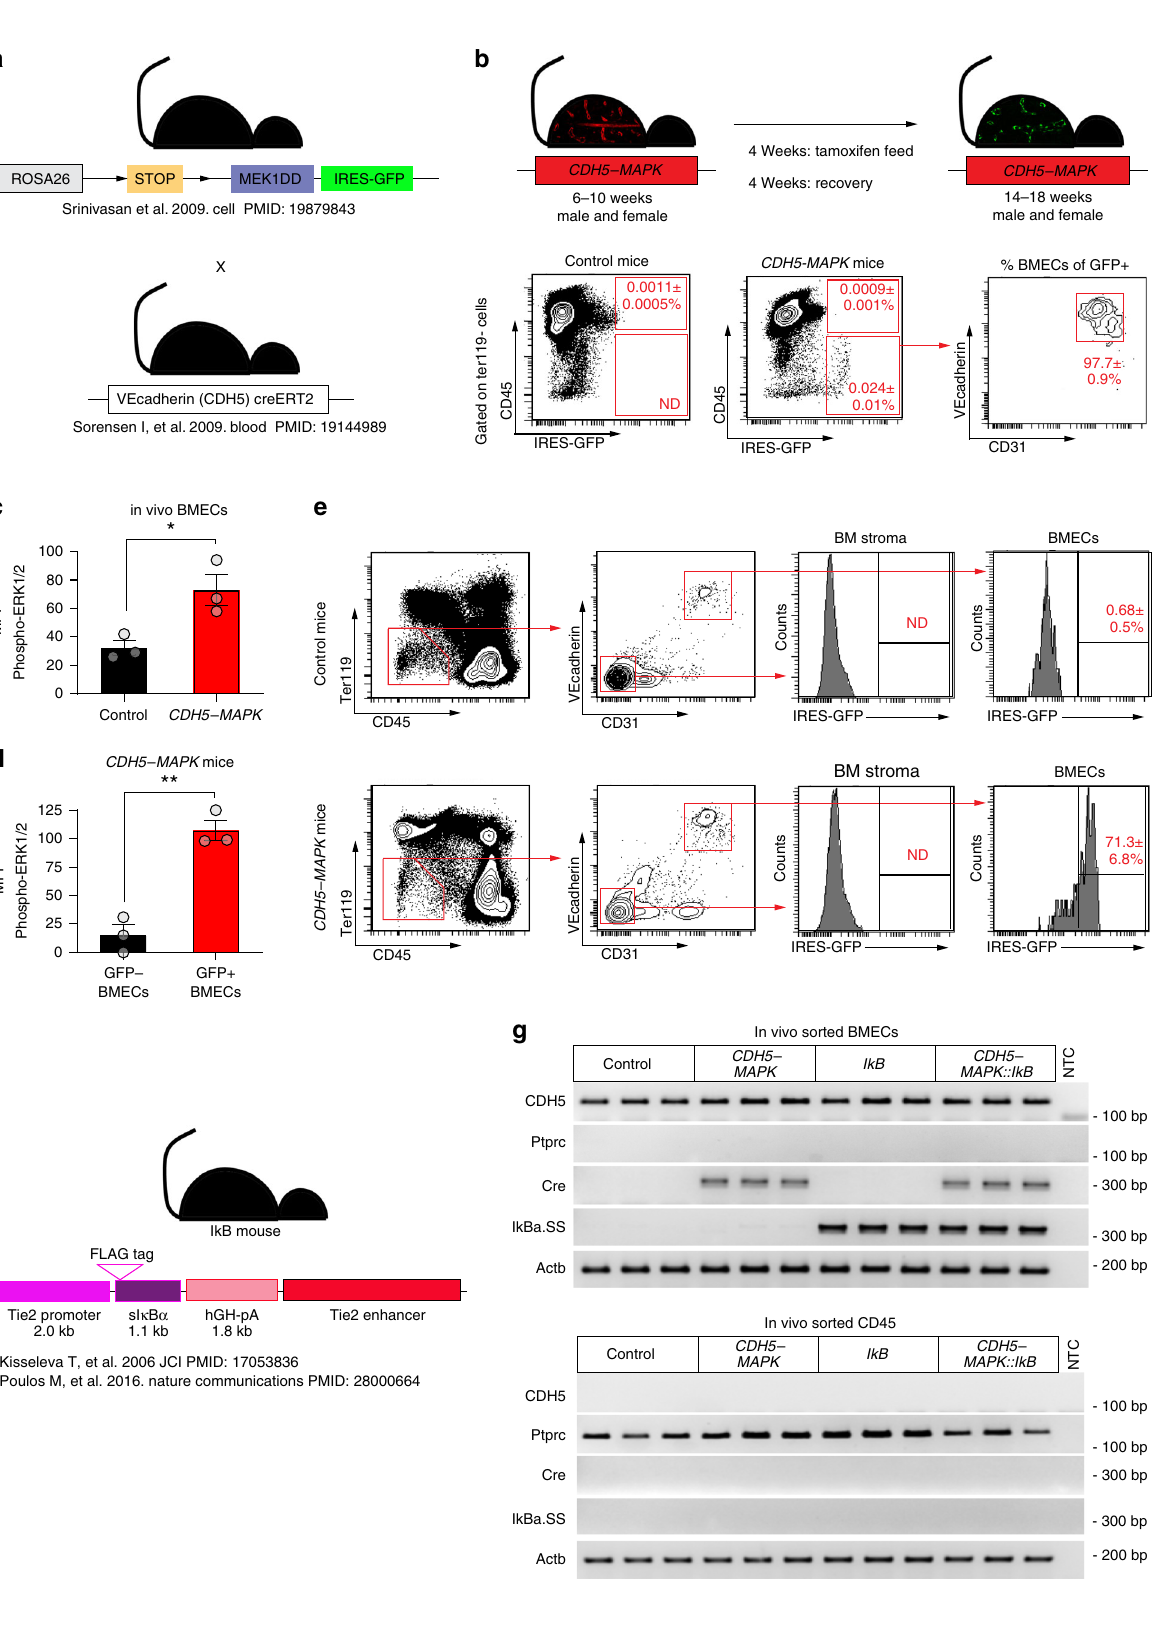
hypoxia (Fig. 7e), indicating that hypoxic injury induced by in fl ammation impacted both HSPCs and niche cells. Interestingly, niche cells did not display signi fi cant changes in ROS levels (Fig. 7f), indicative of a either a higher ROS detoxi fi cation ability or an impaired production in response to in fl ammatory stress.